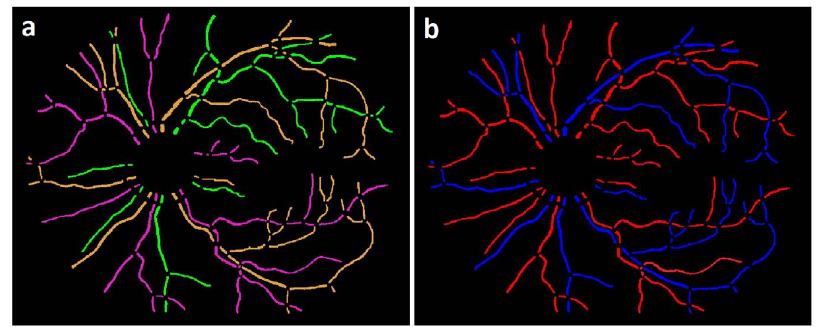
Figure 10. Image example: a) Structural mapping b) Artery-Venous Classification.